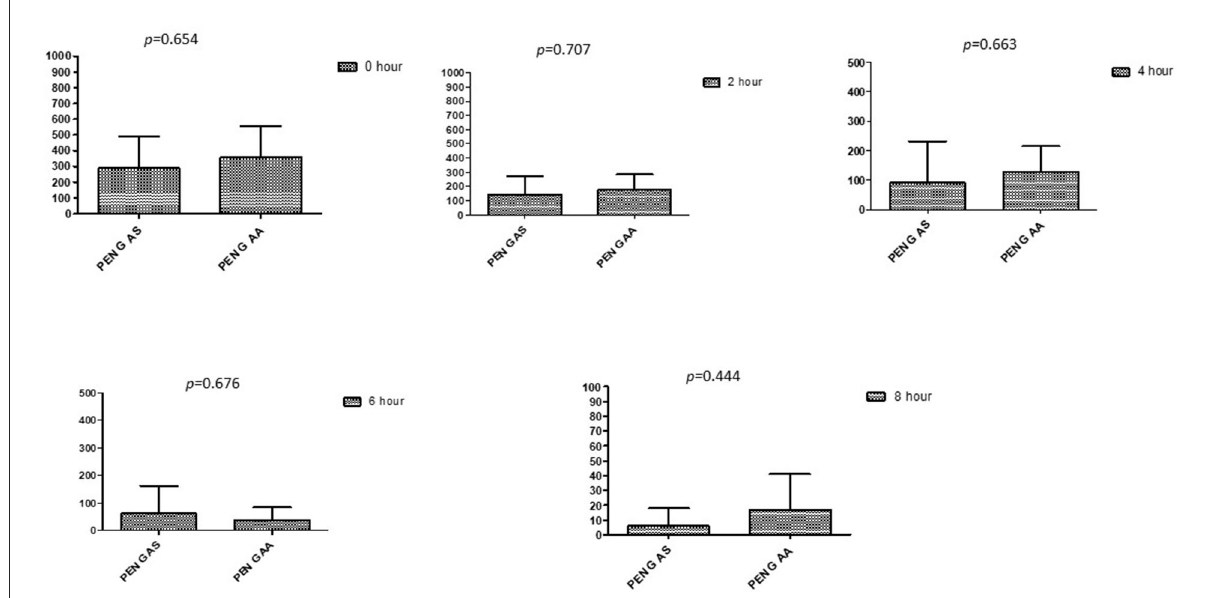
FIGURE9 Comparison of minimum inhibitory concentrations ( µ g/mL) of Penicillin G when combined with AA and AS on E. coli. PEN G-AS, Penicillin G combined with AS; PEN G-AA, Penicillin G combined with AA; p < 0.05 indicate a significant difference among MICs of antibiotic combined with AS and